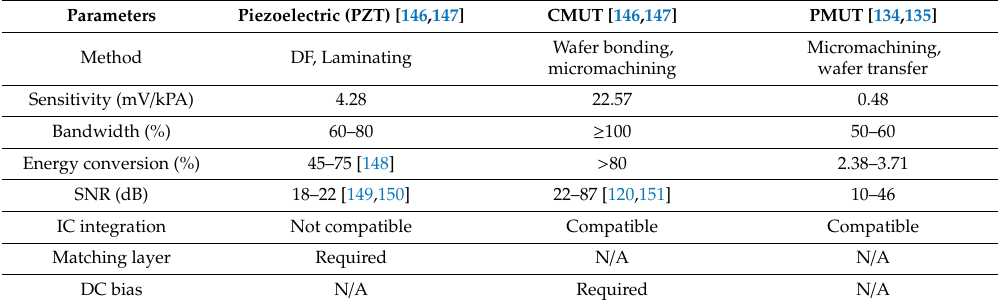
Table 5. Comparison between physical ultrasound transducer technologies. DF: dice and fill, IC: integrated circuit, DC: direct